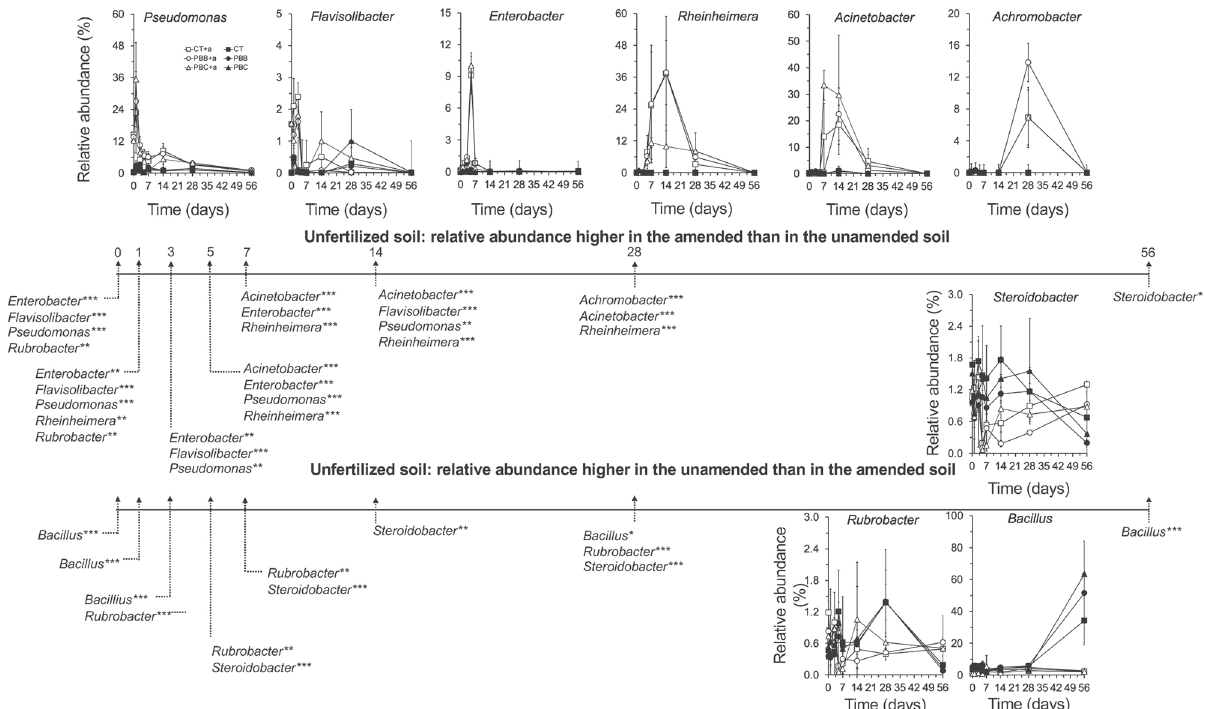
Figure 4. Changes in the relative abundance (%) of bacterial genera in the unfertilized soil with conventional tilled beds and crop residue retained (CT) left unamended (filled black square) or amended with 300 mg NH 4 + -N (open square), permanent beds with crop residue burned (PBB) left unamended (filled black circle) or amended with 300 mg NH 4 + -N (open circle) and permanent beds with crop retained incubated left unamended (filled black triangle) or amended with 300 mg NH 4 + -N (open triangle) incubated aerobically at 25 ± 2 °C for 56 days. A non-parametric test (aldex.kw function; Kruskal Wallis test) in the ALDEx2 package 14 was used